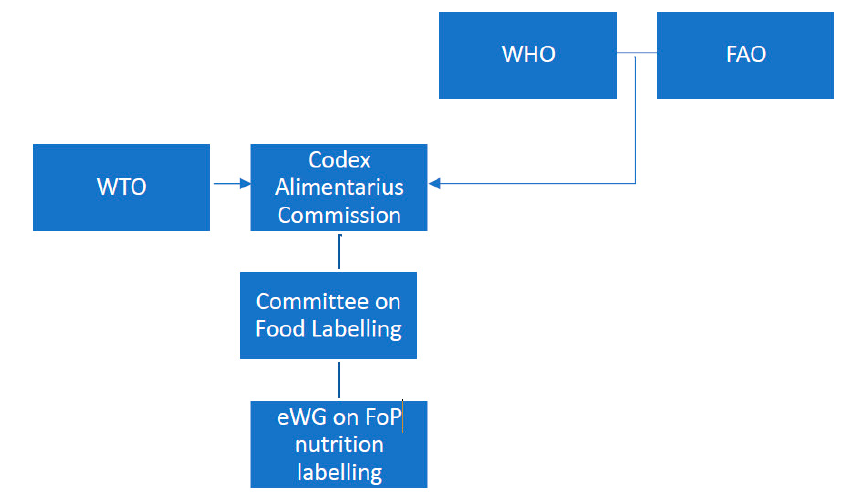
Figure 1. Summary of institutional relationships relevant to FoP nutrition labelling. Abbreviations: WTO–World Trade Organization, WHO–World Health Organization, FAO–Food and Agriculture Organization of the United Nations, eWG–electronic Working Group, FoP–Front of Pack.